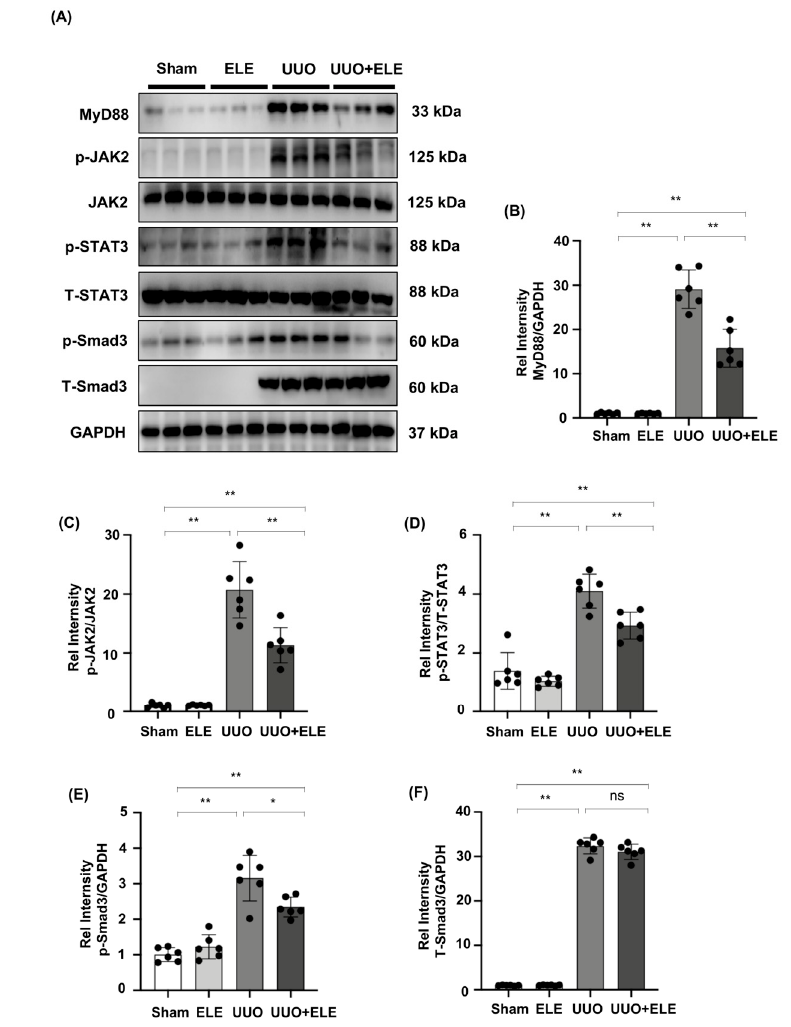
Figure 4. β -elemene inhibited the activation of JAK2/STAT3 signaling and reduced the expression of Smad3/MyD88 in the UUO model. ( A ) Expression of MyD88, p-JAK2, JAK2, p-STAT3, T-STAT3, p-Smad3, and T-Smad3 in the kidney model was detected by western blot and quantified by densitometry. ( B – F ) Statistical significance was presented as the mean ± SD, n = 6. * p < 0.05, ** p < 0.01, ns: no significance. Mice in the ELE and UUO + ELE group were treated intraperitoneally with β -elemene at a dose of 40 mg/kg/d for 7 days, 24 h before and after surgery. All mice had their kidneys harvested on day 7. ELE, β -elemene.